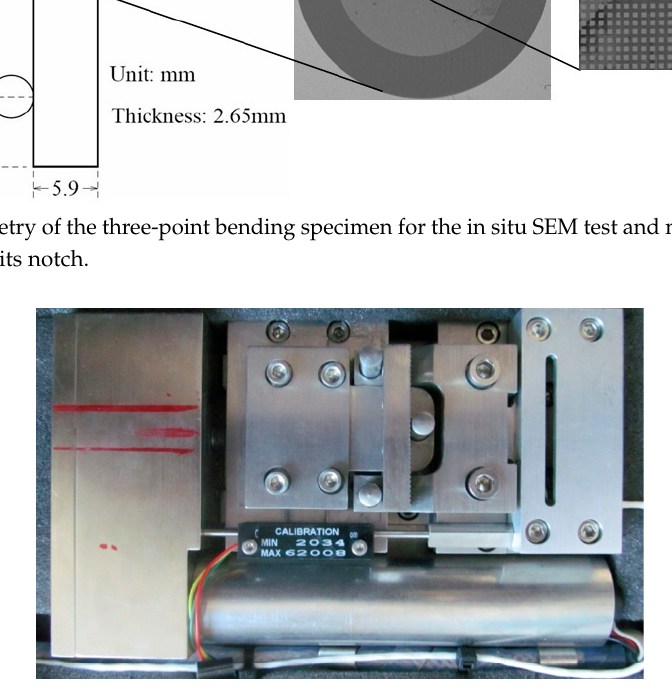
Figure 1. Geometry of the three-point bending specimen for the in situ SEM test and microscale grating pattern around its notch.